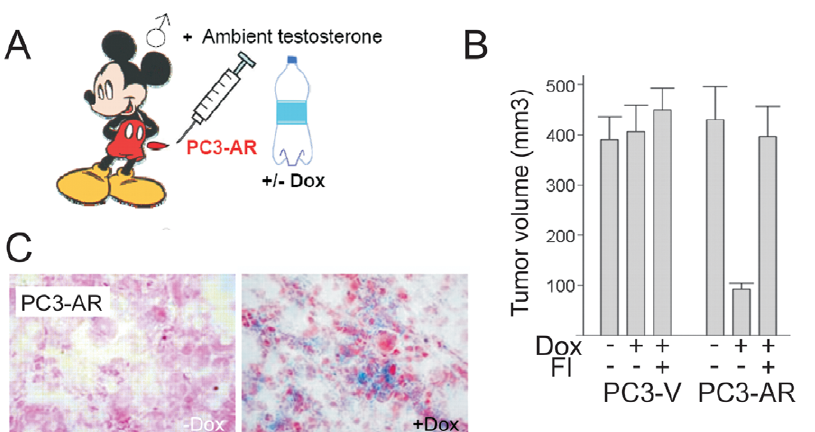
Figure 2. AR-dependent tumor suppression was associated with increased cellular senescence. AR increased cellular senescence in vivo. (A) Experimental design. Male athymic mice (nu/nu, 5 mice/group) were injected s.c. with vector control (PC3-V) or PC3-AR cells and received Dox with drinking water, where indicated, to induce AR expression. Flutamide was given to counteract endogenous testosterone. (B) Mean tumor volumes and standard deviations are shown at 45-day time point. Note lower volume of PC3-AR tumors in male mice treated with Dox, and the lack of the decrease when Fl was added to the treatment. (C) Sections of frozen tumors collected in the experiments above were subjected to SA- b Gal assay to detect senescence. Note increased b Gal positivity (blue) in PC3-AR tumors treated with Dox and of LNCaP tumors treated with